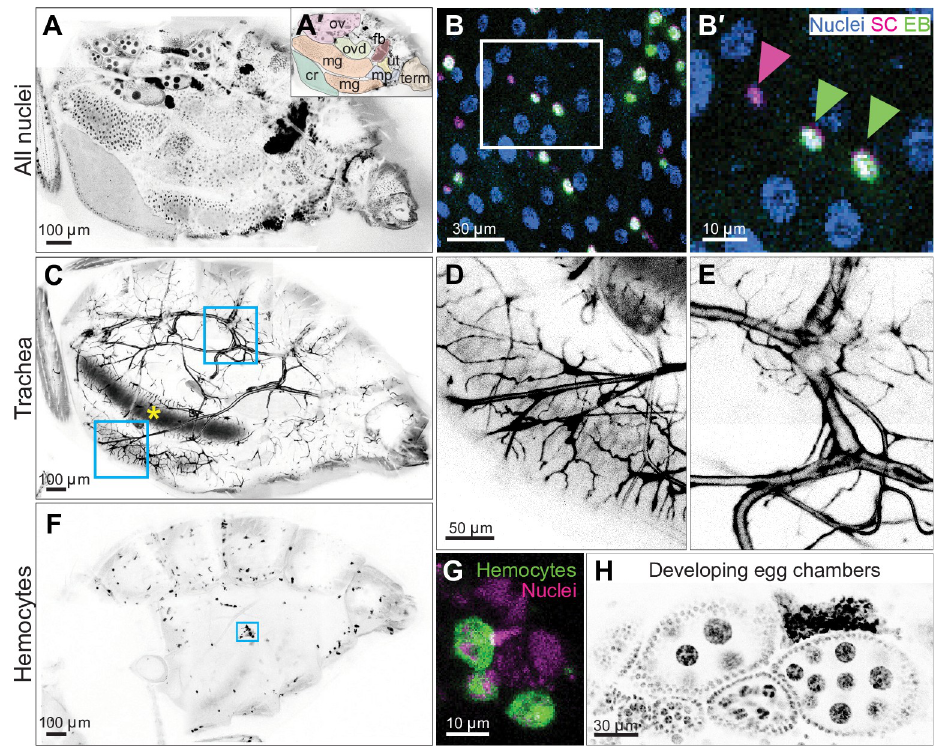
Fig 2. Whole-abdomen, micron-resolution imaging of organs, tissues, and cells in live, intact animals. (A) Native arrangement of abdominal organs. Visible organs include the crop (cr), midgut (mg), ovary (ov), oviduct (ovd), fat body (fb), uterus (ut), Malphigian tubules (mp), and terminalia (term). Inverted grayscale, nuclei. Genotype: esg > his2b :: CFP , GBE-Su(H)-GFP :: nls; ubi-his2av :: mRFP (only RFP is shown). See S5 Movie. (B) Nuclear morphologies of individual midgut cells. Immature diploid cells (SCs [magenta nuclei] and terminal EBs [green nuclei]) were dispersed among mature, polyploid enterocytes (blue nuclei). Right panel is a close-up of boxed region in left panel. Arrowheads indicate nuclei of a stem cell (magenta) and two enteroblasts (green). Genotype: esg > his2b :: CFP , GBE-Su (H)-GFP :: nls; ubi-his2av :: mRFP . (C) The abdominal tracheal network. Whole-abdomen imaging showed connectivity of tracheal branches from cuticular spiracles to internal organs. Ingested food in the midgut lumen exhibited autofluorescence (yellow asterisk). Boxed areas are shown as close-ups in D and E. (D) An extensive network of secondary and tertiary trachea wrap around the midgut tube. (E) Primary trachea exhibit branching near their origin at the cuticular spiracle. Genotype in C–E: breathless > GFP ; ubi-his2av::mRFP (only GFP is shown). (F) Whole- abdomen distribution of hemocytes. Individual hemocytes tended to localize to pigmented regions of abdominal tergites. (G) Morphology of individual hemocytes. Image is a close-up of boxed region in F. Scale bar, 30 μ m. Genotype in F–G: hml > GFP ; ubi-his2av :: mRFP (only the GFP channel is shown in F). (H) Developing egg chambers. Each chamber included the immature oocyte and polyploid nurse cells that are surrounded by diploid follicle cells. Four chambers, arranged by developmental stage, are aligned within one ovariole at the bottom. One chamber from a different ovariole is at the top. Nuclei, inverted grayscale. Genotype: ubi-his2av :: mRFP . See S6 Movie. All images are projections of confocal stacks. CFP , cyan fluorescent protein; EB, enteroblast; esg , escargot- Gal4; GBE , Grainyhead binding element; GFP , green fluorescent protein; hml , hemolectin; his2av , histone variant His2av; mRFP , monomeric red fluorescent protein; nls , nuclear localization sequence; RFP , red fluorescent protein; SC, stem cell; Su(H) , Suppressor of